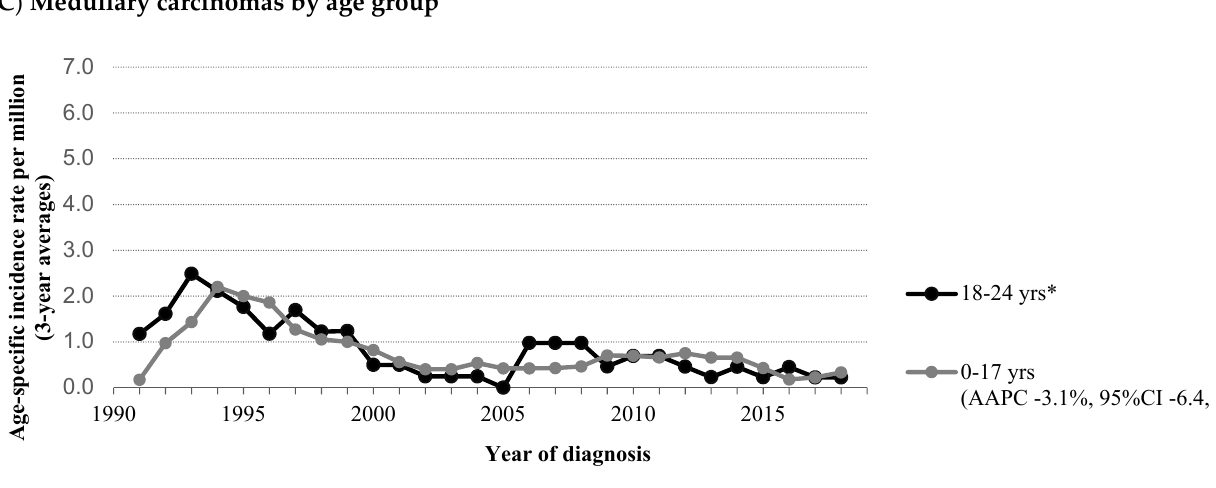
Figure 2. Time trends in incidence of patients aged 0–24 years with thyroid carcinoma by histology and age in the Netherlands, 1990–2019. ( A ) Papillary thyroid carcinoma. ( B ) Follicular thyroid carcinoma. ( C ) Medullary thyroid carcinoma. Abbreviations: AAPC, average annual percent change; CI, confidence interval. Three-year moving averages of the age-specific incidence rate of thyroid carcinoma are shown. The incidence rates of the patients 0–9 and 0–17 years are age-standardized according to the World Standard Population. AAPC was estimated from a regression line, which was fitted to the natural logarithm of the rates using year of diagnosis as a regressor variable. * Estimation of a reliable average annual percentage change was not possible because of n = 0 in >5 incidence years.